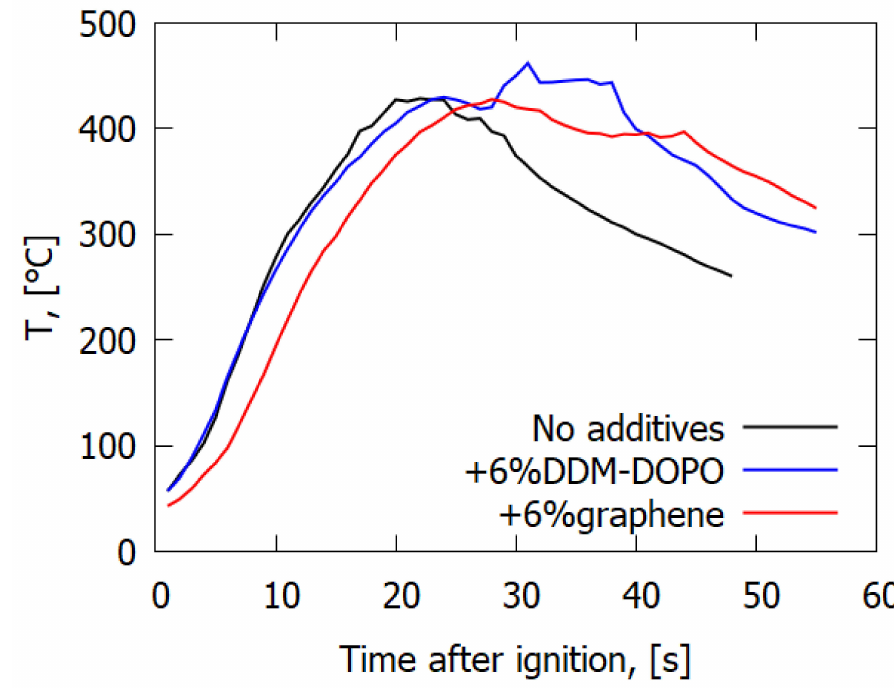
Figure 7. Dependence of the sample surface temperature on time in a VBB test for